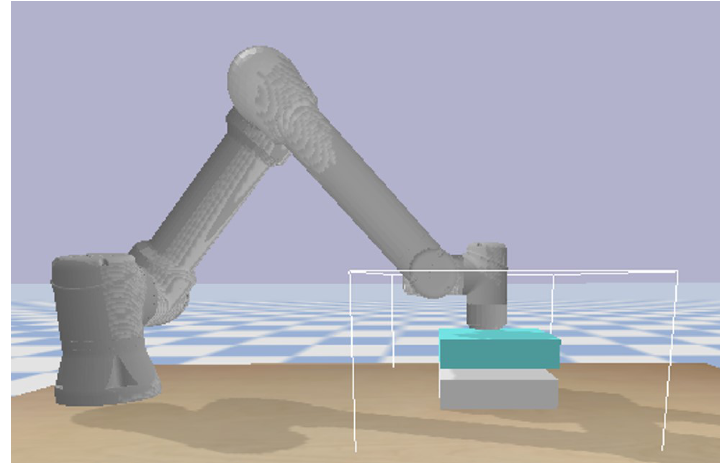
Figure 4. Simulation environment.